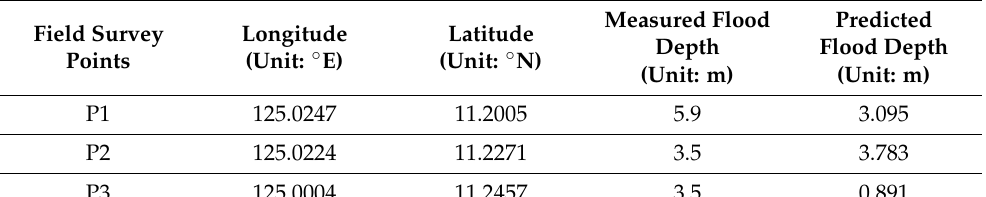
Table 5. Measured and predicated flood depths at P1, P2, and P3. The measured flood depths are from [44].